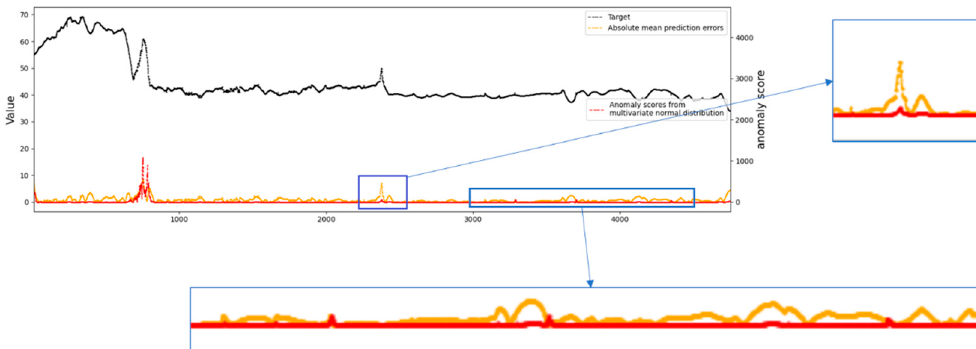
Figure 10. LSTM abnormal score effect.